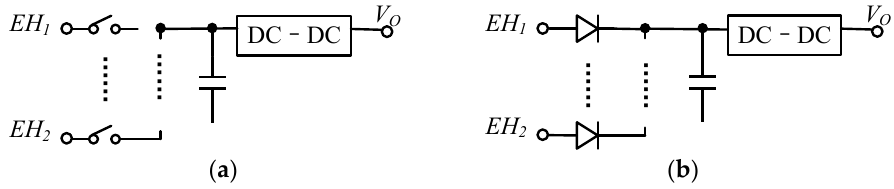
Figure 18. Architecture of energy combining ( a ) diode-connected, ( b ) switch-connected. The switched-inductor converter structure can be used in combiners, to enable sim- ultaneous multi-source acquisition. A single-inductor multiple-input multiple-output (SIMIMO) converter, with four harvesters, one battery input, and three outputs of 1.8V, 3.3V, and one battery, respectively, is proposed in [88] for the MPPT operation, and mul- tiple inputs can be acquired simultaneously. The structure of the inductor-based combiner is shown in Figure 19a.